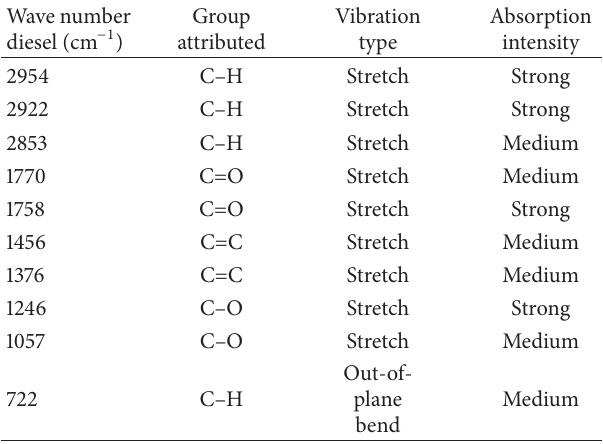
Table 4: FTIR wave numbers for different peaks of regular